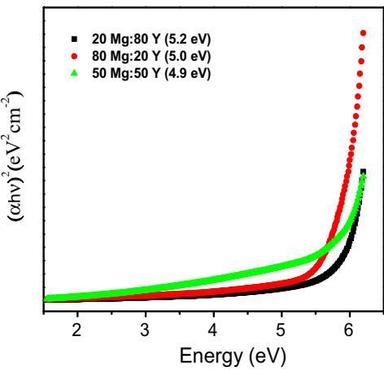
Optical band gap energy of the produced MgO-Y2O3 nanocomposite at different Mg2+ ion content (a) 20 Mg:80Y, (b) 50 Mg:50Y and (c) 80 Mg:20 Y annealed at 600 C for 2 h.